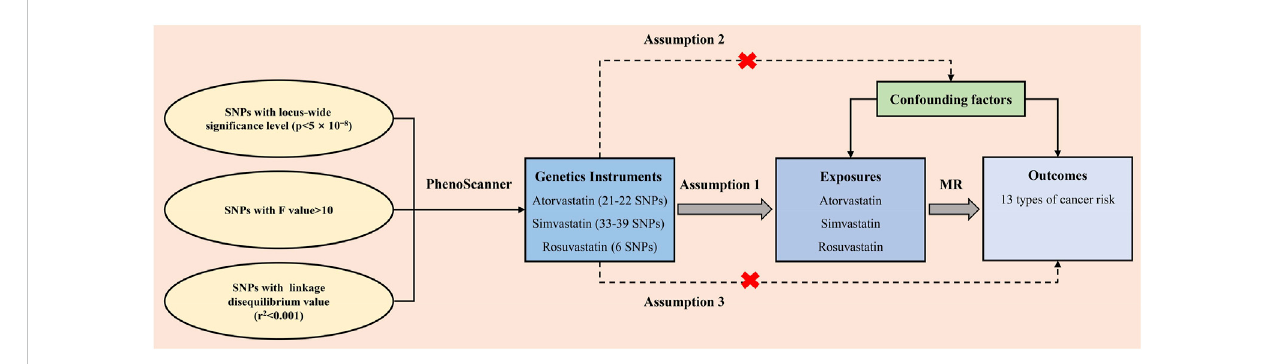
FIGURE 2 The three assumptions for the two-sample Mendelian randomization analysis in this study. SNP: single-nucleotide polymorphism; MR: Mendelian